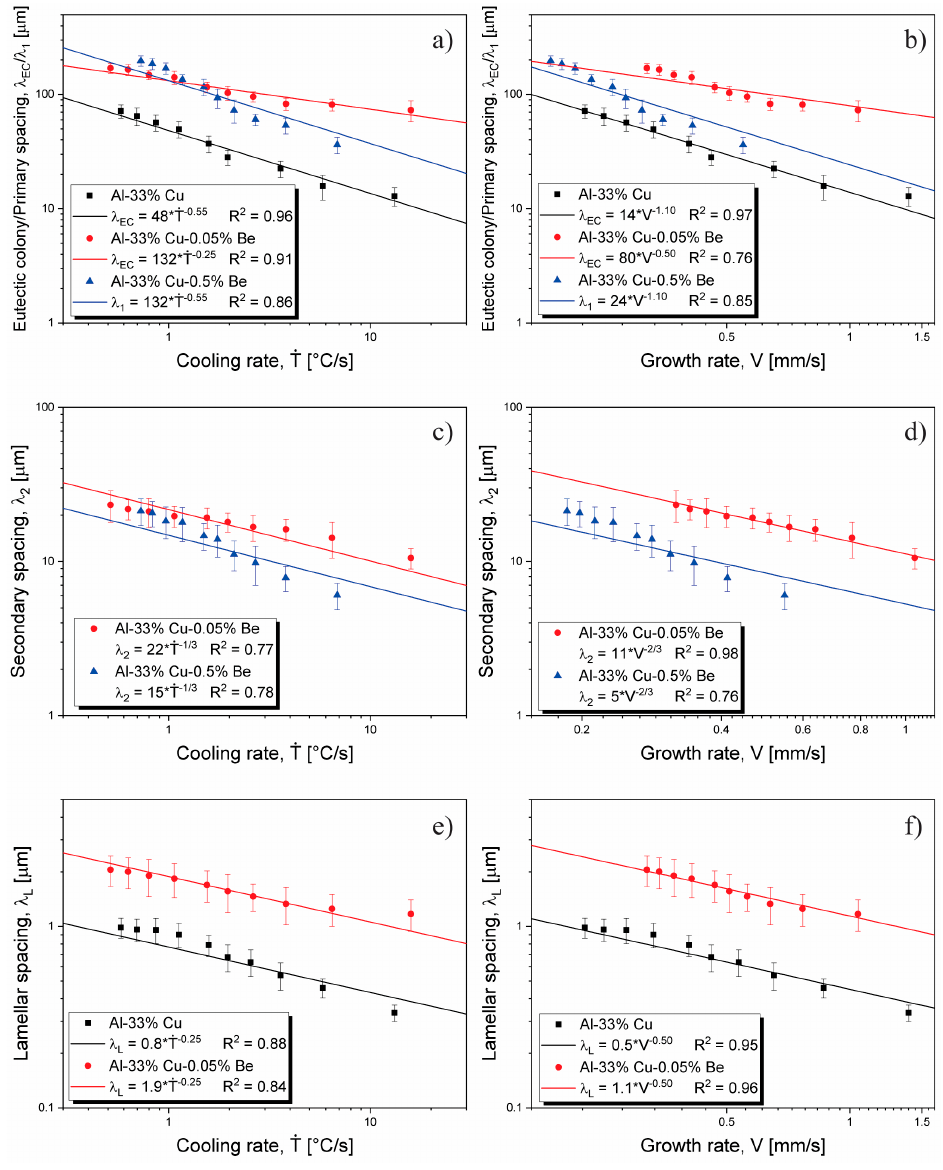
Figure 8. Eutectic colony/primary dendritic spacing, λ EC / λ 1 , as a function of ( a ) ˙T and ( b ) V, lamellar spacing, λ L , as a function of ( c ) ˙T and ( d ) V and secondary dendritic spacing, λ 2 , as a function of ( e ) ˙T and ( f ) V for Al-33 wt.%Cu data from [19], Al-33 wt.%Cu-0.05 wt.%Be and Al-33 wt.%Cu-0.5 wt.%Be